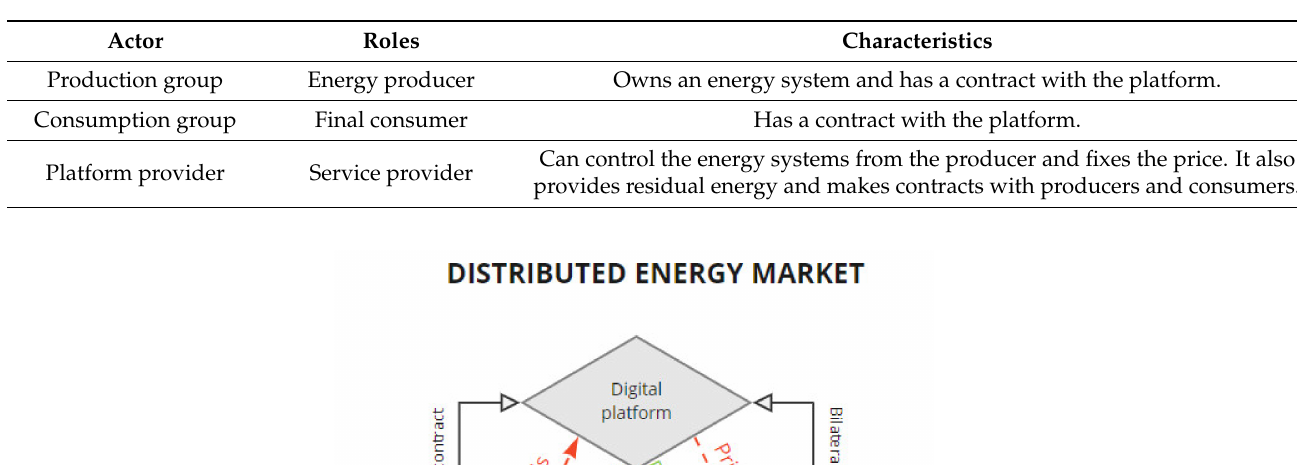
Table 10. Characteristics of the actors’ roles for the distributed P2P-ET market. Table based on own interpretation from Section 2.2.3.